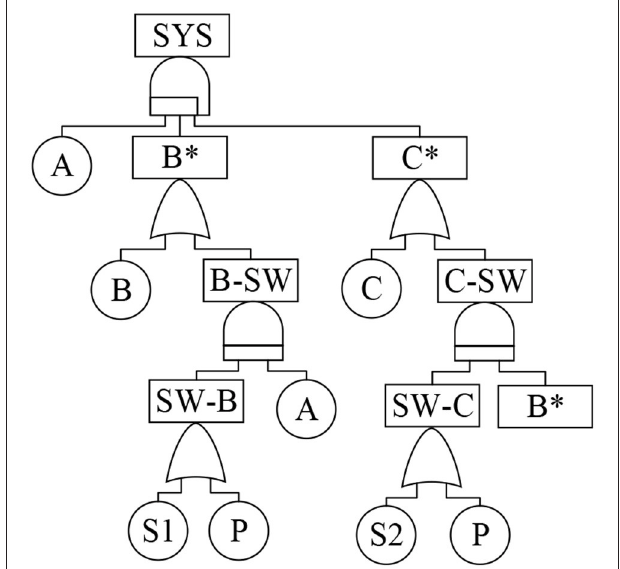
FIGURE 5 | FT for case